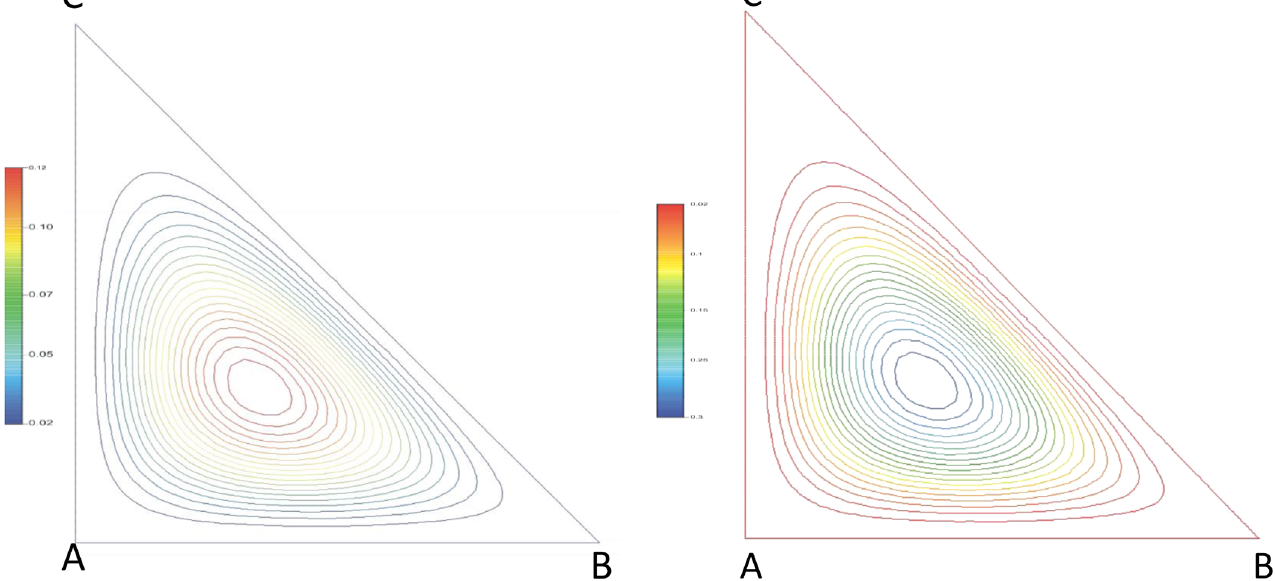
¼ 0 , BC, u =0, CA, u =1, n